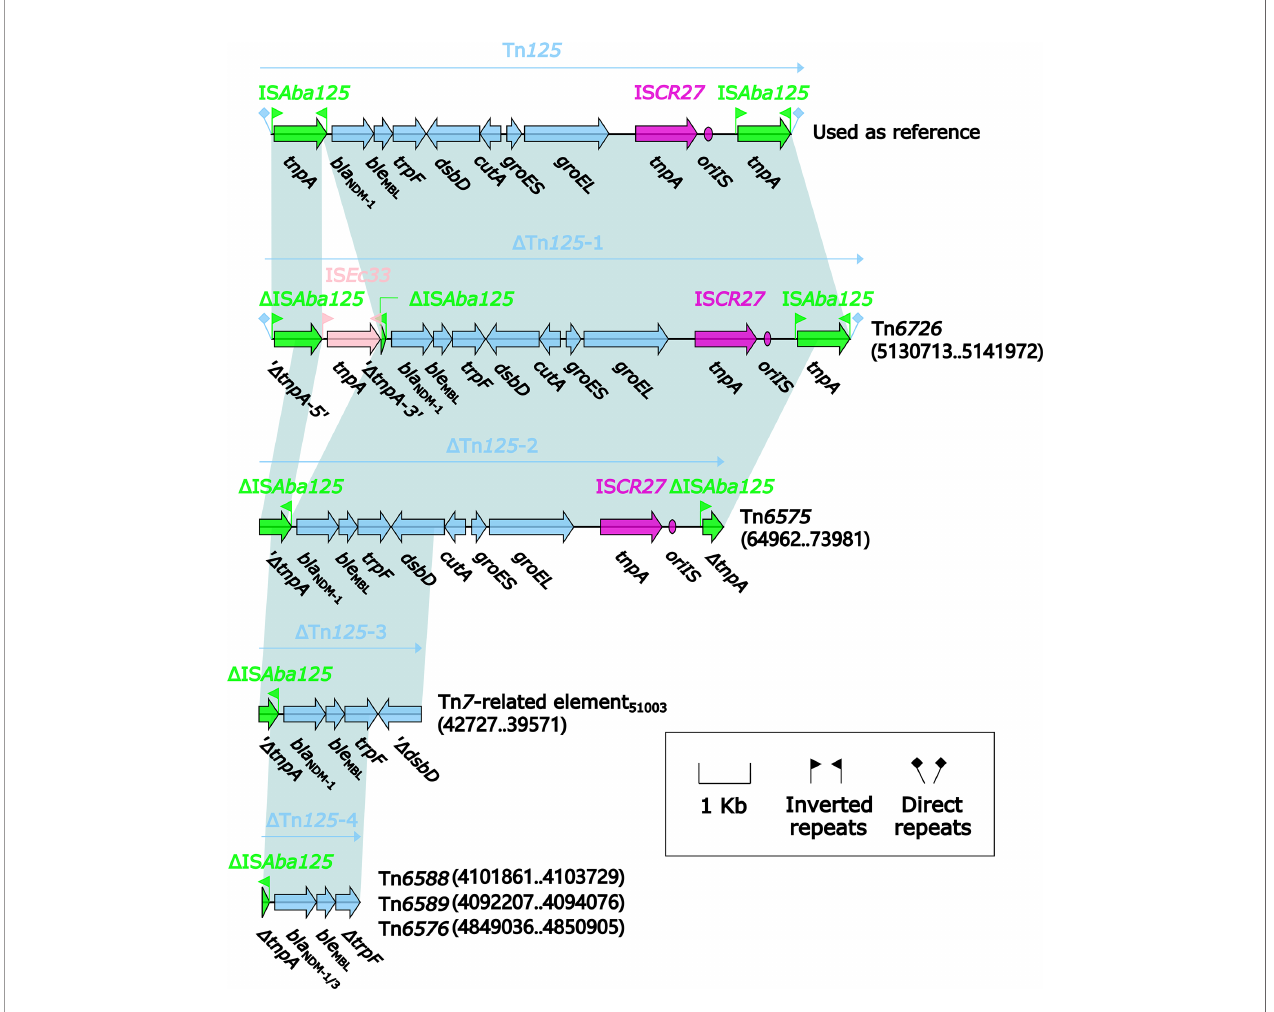
FIGURE 12 | Comparison of Tn 125 and its four derivatives. Genes are denoted by arrows. Genes, mobile elements, and other features are colored based on their functional classi fi cation. Shading denotes regions of homology (nucleotide identity ≥ 95%). Numbers in brackets indicate nucleotide positions within Tn 6575 and the chromosomes of strains KP64, 51003, 1701091, 1701092, and QD23, respectively. The accession number of Tn 125 (Poirel et al., 2012) used as reference is